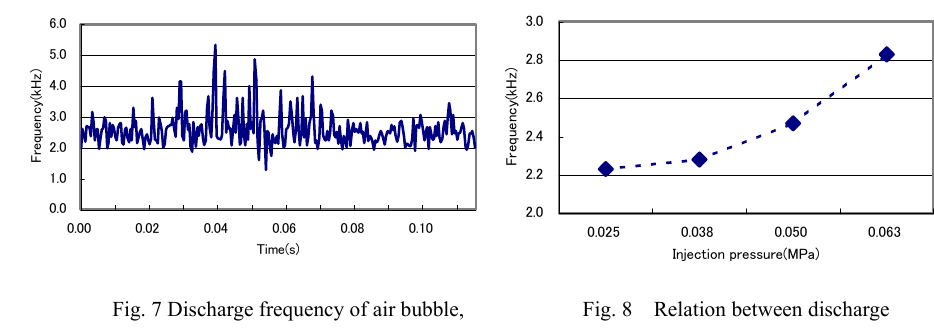
Fig. 7 Discharge frequency of air bubble, P a =0.05MPa, (process Ⅲ～ process Ⅳ )